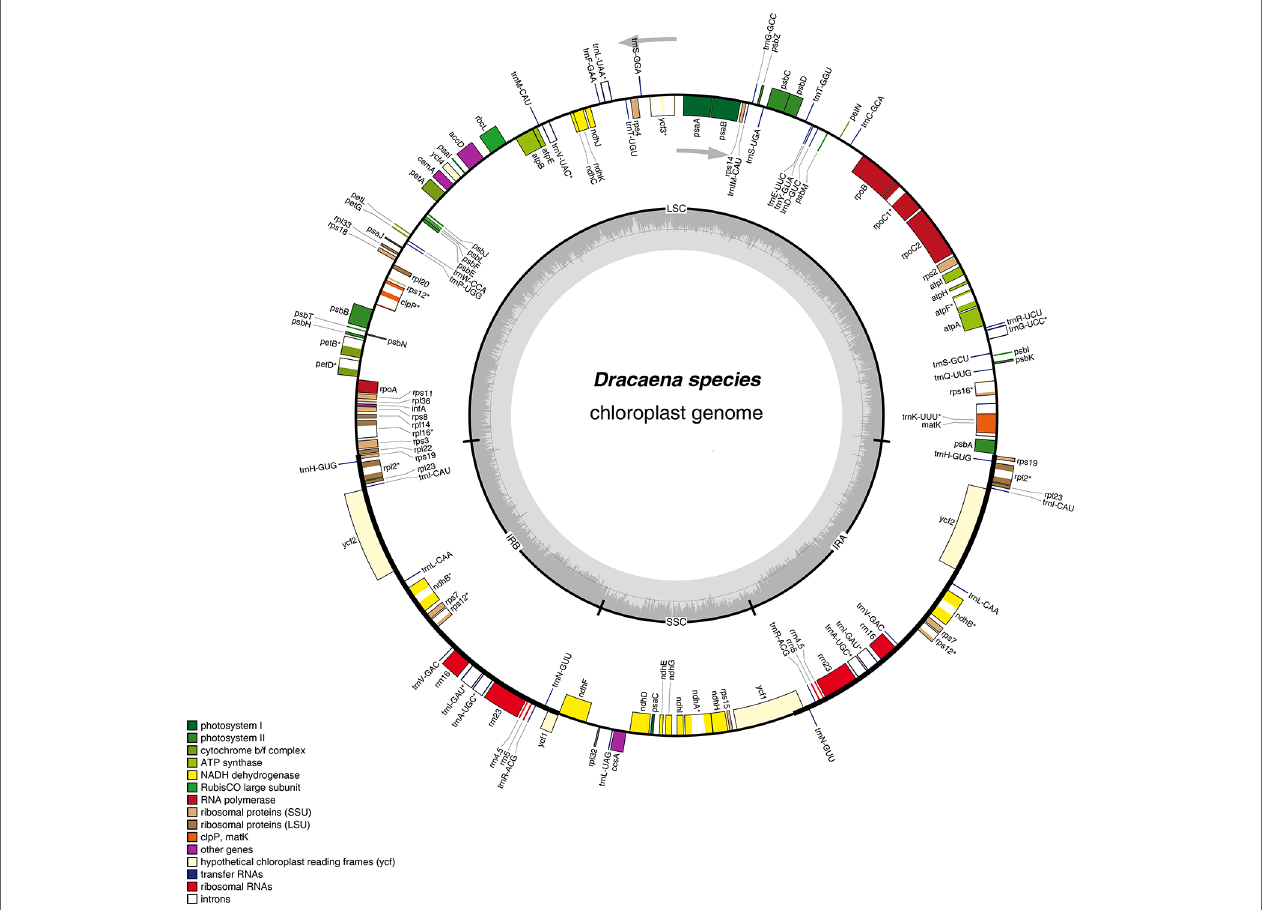
FIGURe 1 | Gene map of the complete chloroplast genomes of Dracaena species. Genes on the inside of the circle are transcribed clockwise, and those on the outside are transcribed counter-clockwise. The darker gray area in the inner circle corresponds to GC content, whereas the lighter gray corresponds to AT content.